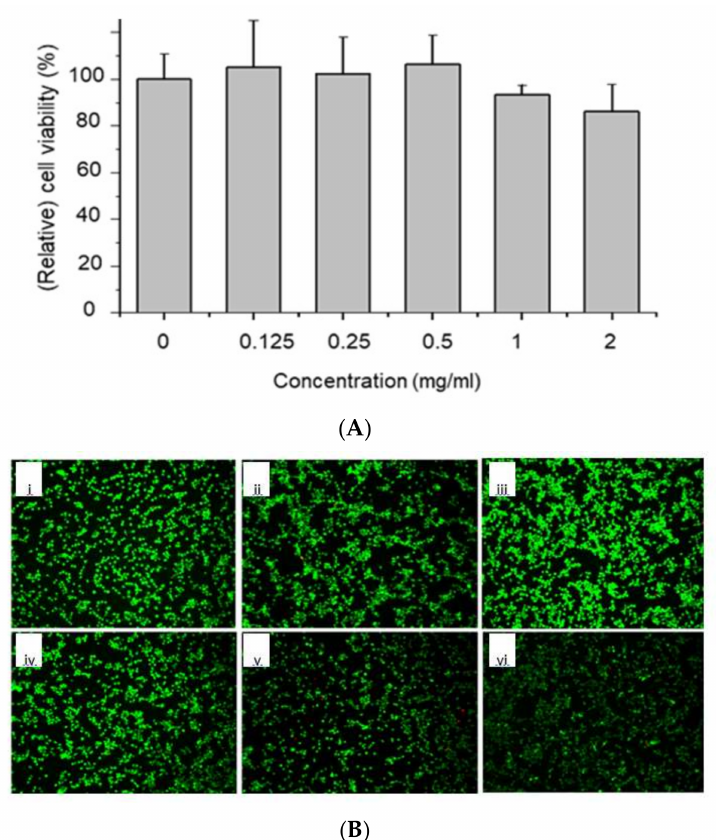
Figure 7. ( A ) Cytocompatibility and ( B ) Live / Dead fluorescence images with (i) 0, (ii) 0.125, (iii) 0.25, (iv) 0.5, (v) 1 and (vi) 2 mg / mL of mag@zcf 1 in vitro culture with